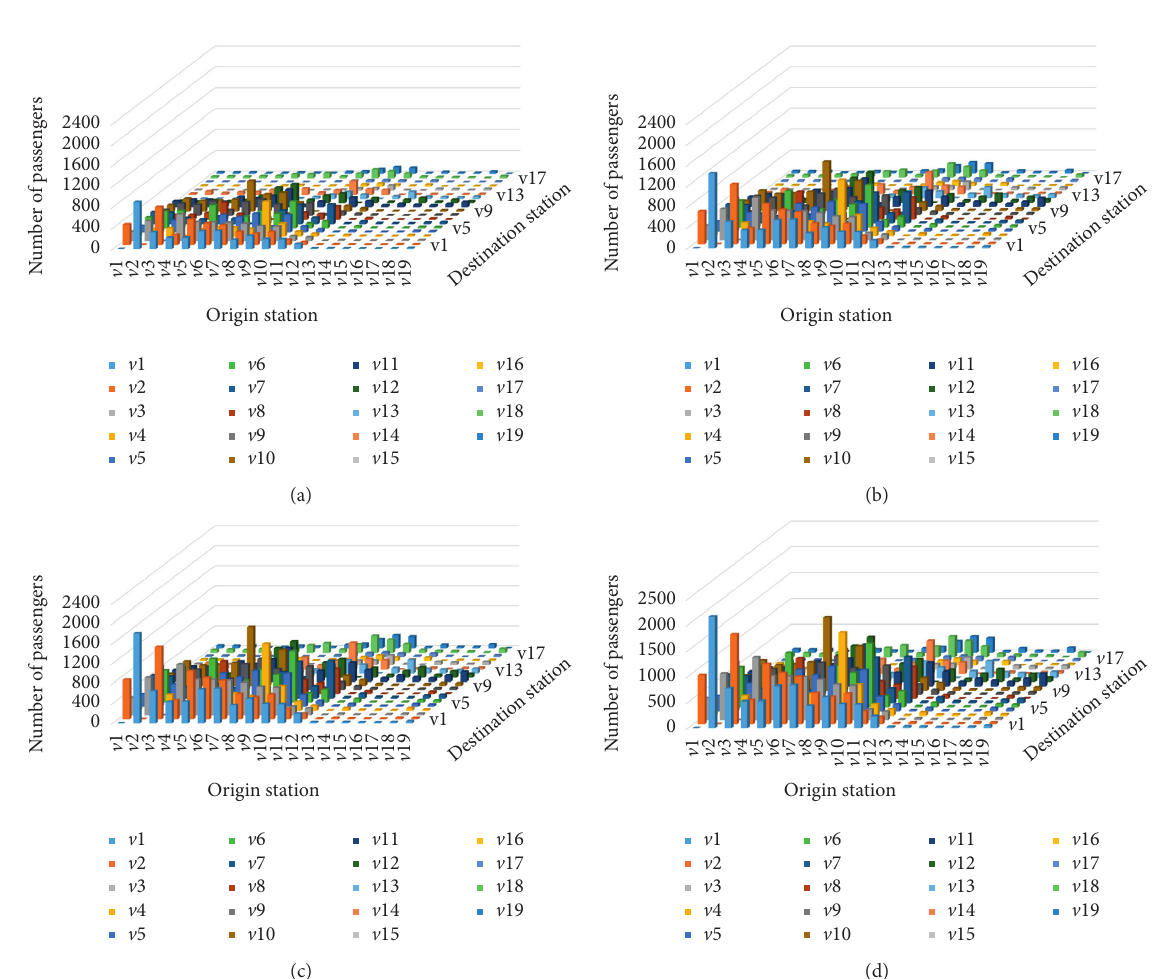
Figure 7: Multiple passenger demand levels. (a) 50% demand with respect to original demand. (b) 80% demand with respect to original demand. (c) Original demand. (d) 120% demand with respect to original demand.